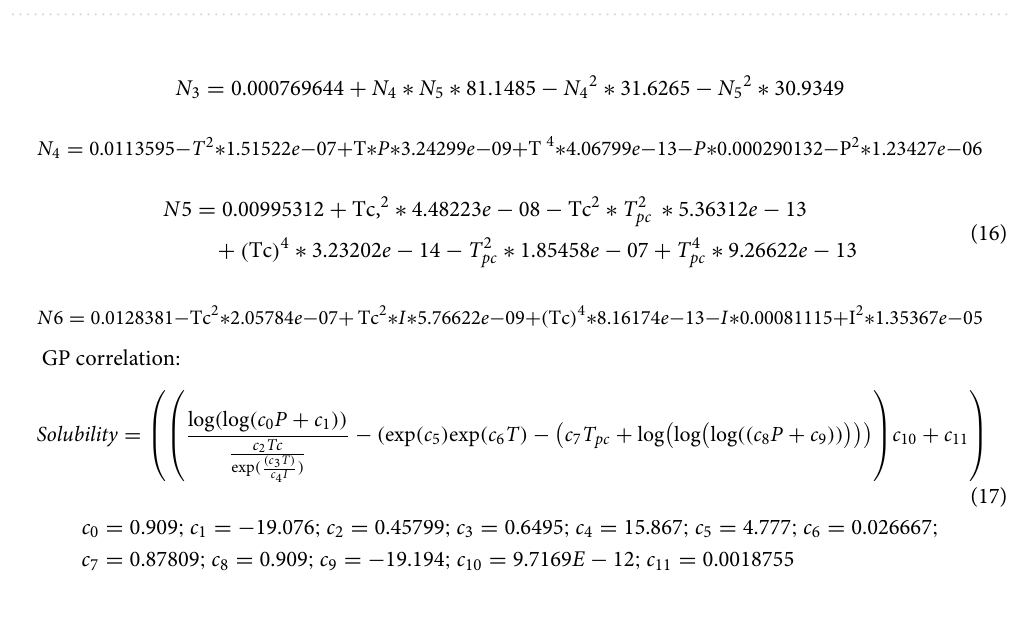
Evaluation of the models. In the current study, R 2 , AAPRE, SD, and RMSE were utilized to appraise the models’ estimates. The results of these statistical criteria for all predictive tools are presented in Table 3. As can be observed in this table, for both modeling approaches, AdaBoost-SVR, Extra Tree, Random Forest, and DT models can be classified in terms of high exactness for predicting the whole dataset, respectively. However, for the test subset, AdaBoost-SVR, Random Forest, DT, and Extra Tree models, respectively, had the best estimates,